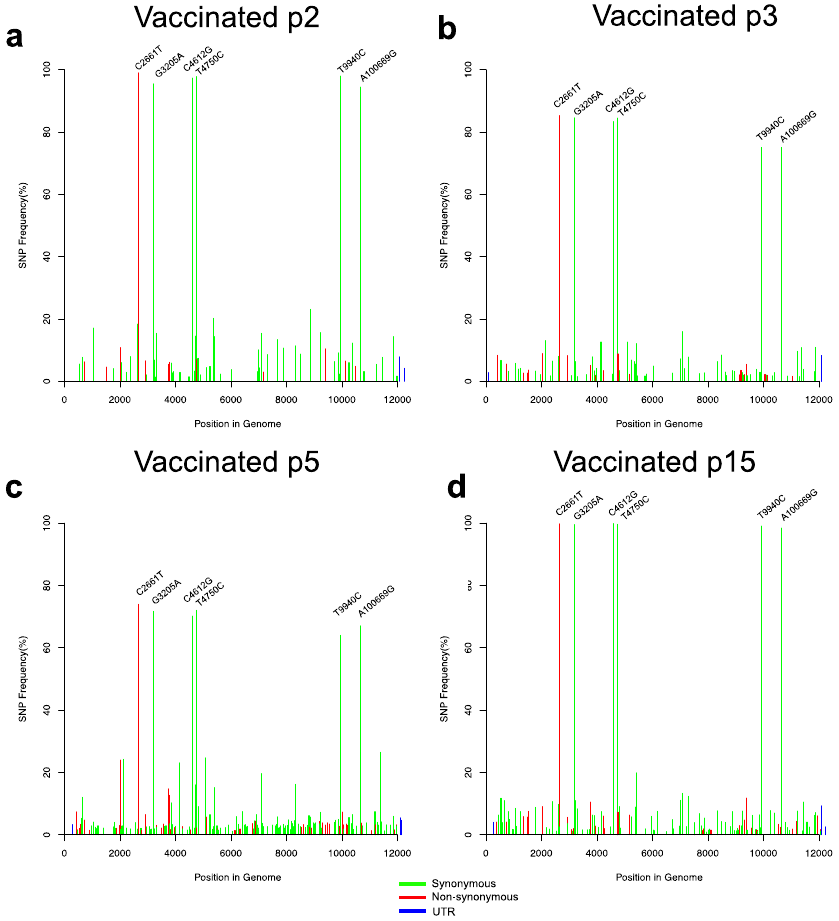
Figure 4. SNP frequency plots of the vaccinated pigs following the virus challenge determined following RT-PCR. SNPs with a frequency above 20% are indicated for each sample type as follows: ( a ) Serum (PID5) from pig p2 previously vaccinated with vR26E2gif. ( b ) Serum (PID5) from pig p3 previously vaccinated with vR26_E2gif. ( c ) Serum (PID5) from pig p5 vaccinated with vR26_E2gif and ( d ) Serum (PID5) from pig p15 vaccinated with vR26. The red, green, and blue colours of the bars represent non-synonymous, synonymous, and untranslated region (UTR) mutations, respectively.